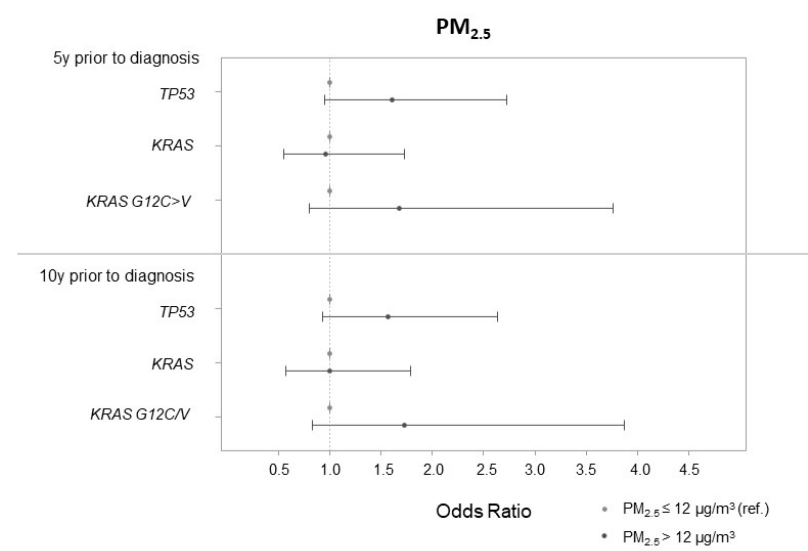
Figure 2. Associations between PM 2.5 in binary according to US EPA guidelines (PM 2.5 > 12 µ g/m 3 5 and 10 years prior to cancer diagnosis) and lung cancer tumor mutations.